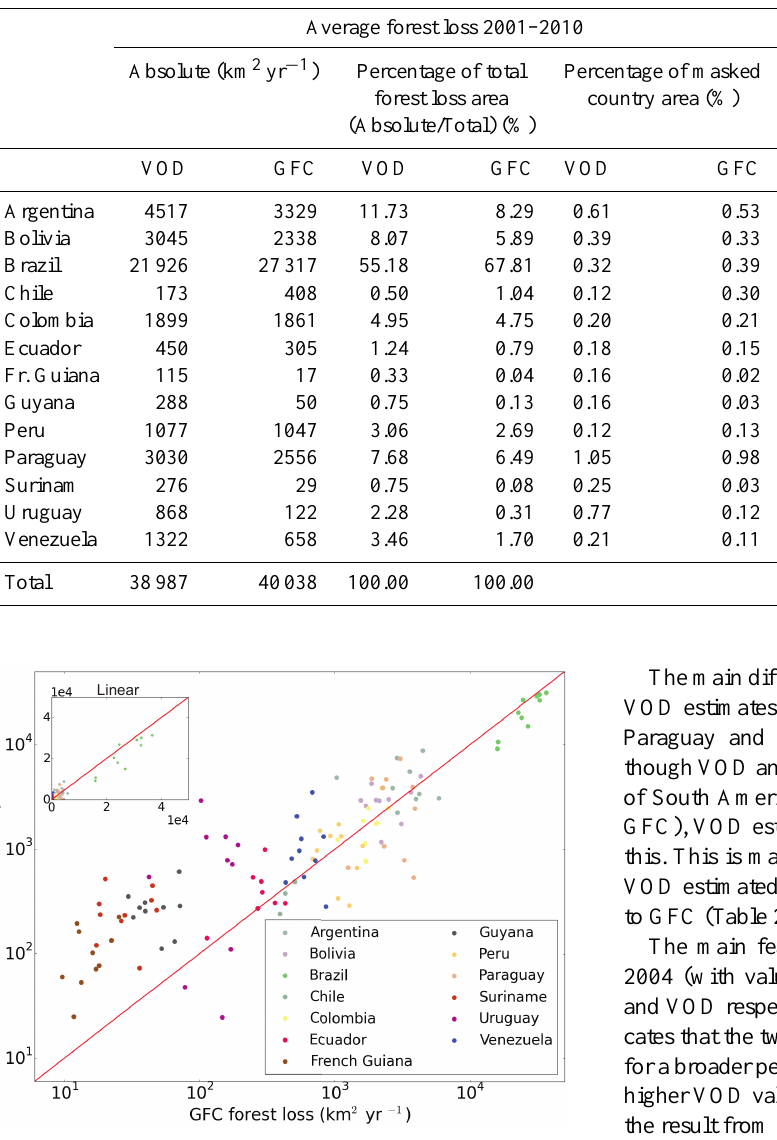
Table 2. Country-level forest loss estimates (total area, contribution to total South American forest loss, contribution of forest loss as a percentage of the masked-country area, as well as absolute and relative trends) for VOD and GFC for the overlapping time period (2001– 2010). Asterisks indicate the significance, where ∗ = p >0.25; ∗∗ = p <0.25; ∗∗∗ = p <0.05.